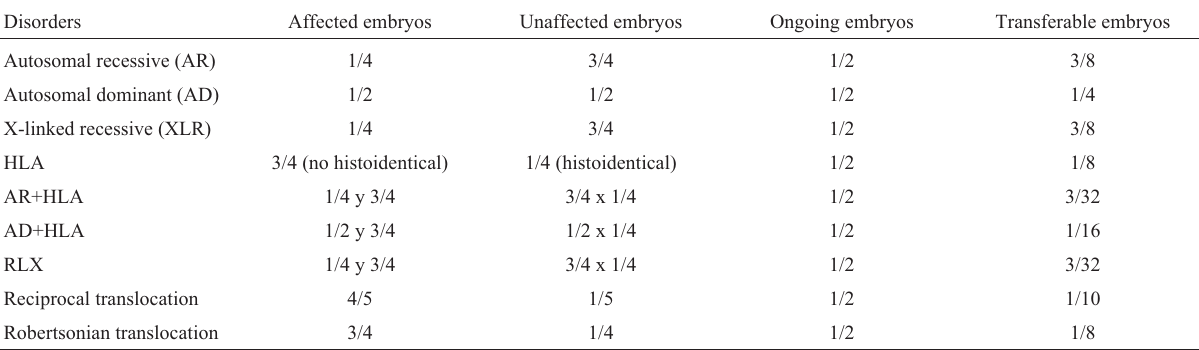
Table 1 - Prediction of the number of transferable unaffected embryos according to the reason for